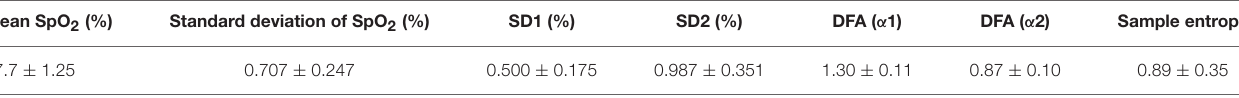
TABLE 1 | Linear and non-linear characteristics of SpO 2 for the study population. Mean SpO 2 (%)